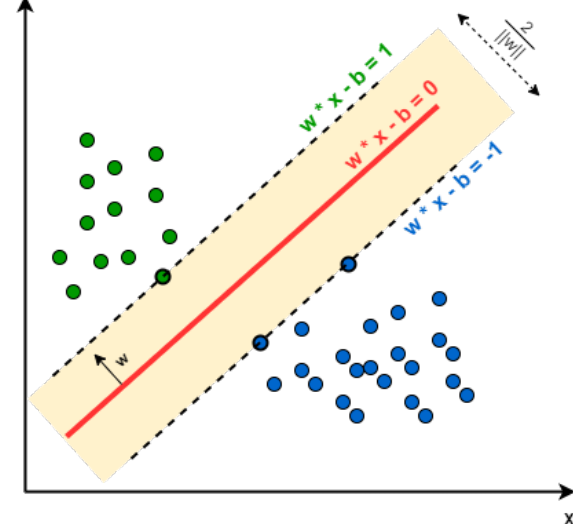
Figure 5. Example scatterplot showing SVM classification of data points into two